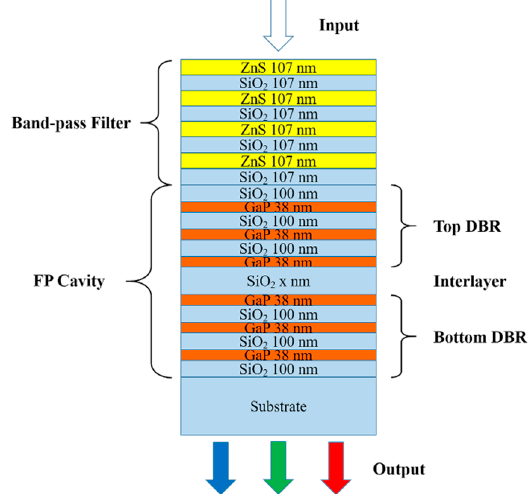
Figure 1. Structural diagram of the device used in simulation.